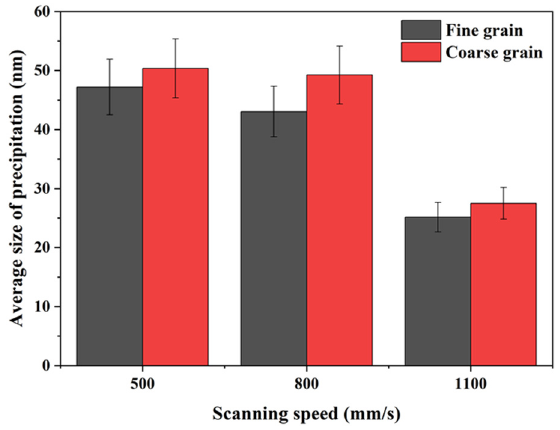
Figure 13. Statistical results of the size of the second phase in Cu–Cr–Nb–Ti alloy samples manufac- tured at different scanning speeds.